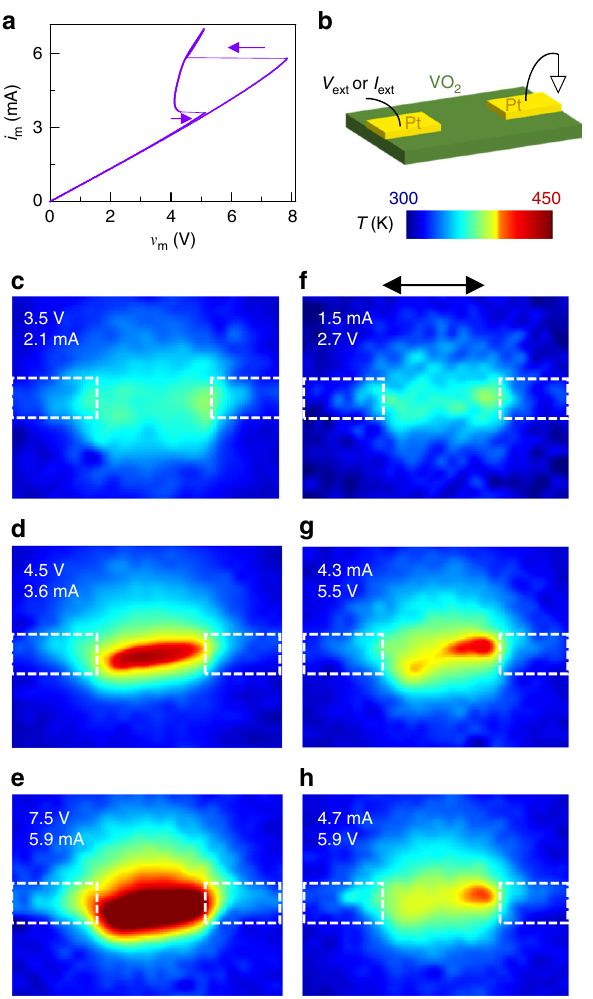
Fig. 4 Current-density- and electric- fi eld-decompositions in VO 2 . a